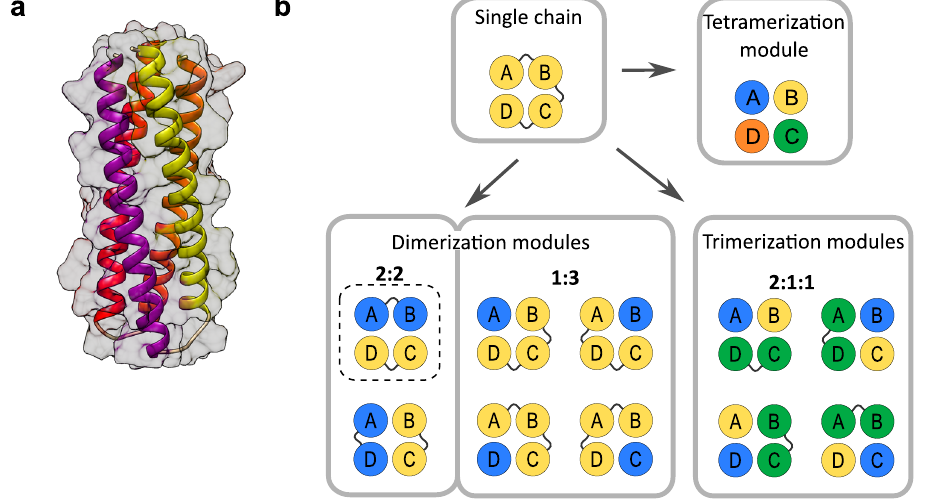
Fig. 1 | Four-helical bundle segmentation strategy for the generation of mul- tiple oligomerization modules. a Crystal structure of DHD13_XAAA 4HB deter- mined by NMR (PDB:6DMP). b Segmentation strategy for 4HB by permutation of